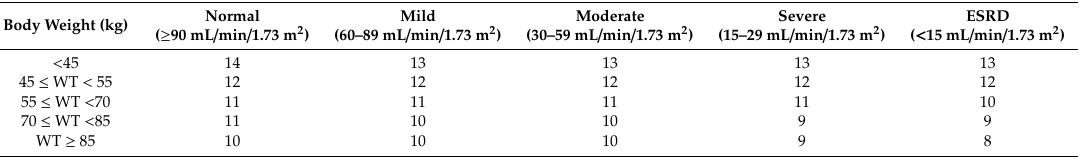
Table 3. Once-daily dosage recommendations based on body weight and renal